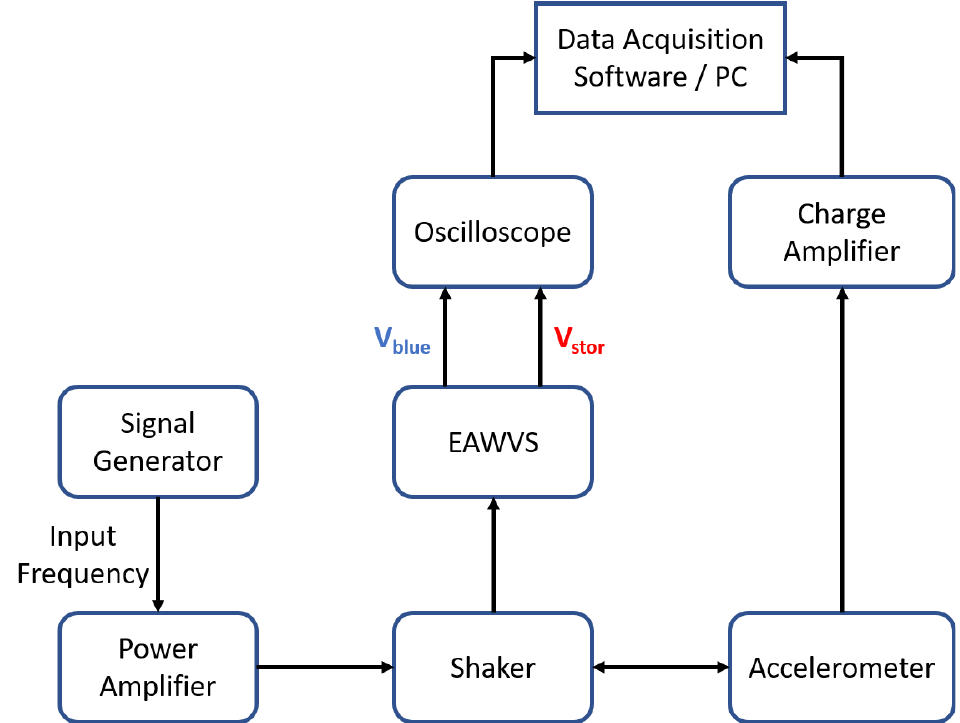
Figure 6. Block diagram of the experimental